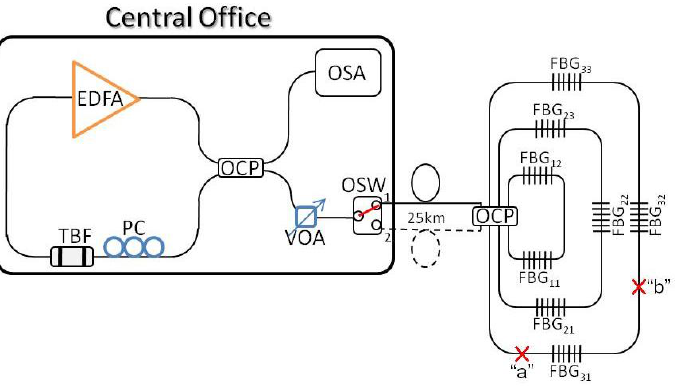
Figure 2. Experimental setup of proposed long distance self-healing FBG-based sensor